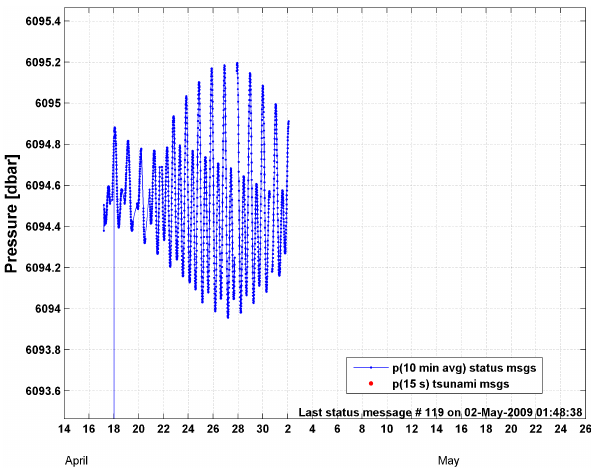
Fig. 14. Summary of 14 days of real time data from position Suma- tra 4. Blue dots represent 10-min pressure averages (transmitted via status messages). Limits of time axis as for figure depicting pres- sure data at Sumatra 3 (Fig.